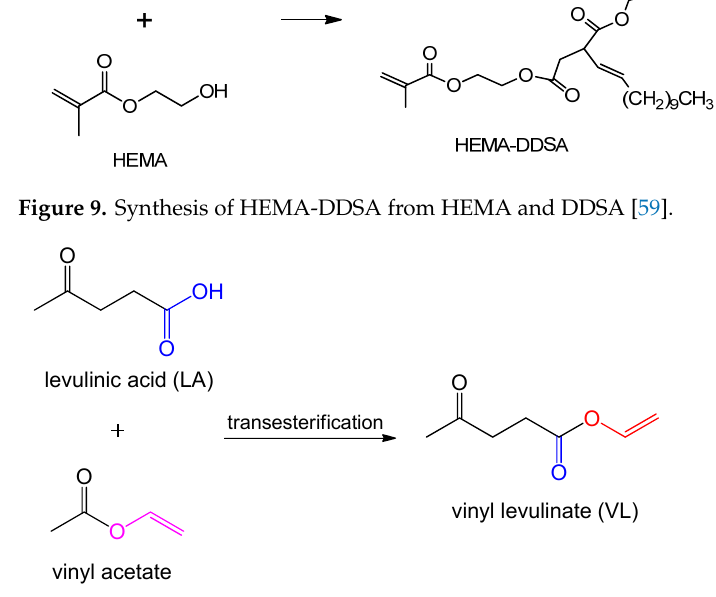
Figure 10. Synthesis of VL from levulinic acid and vinyl acetate [60].